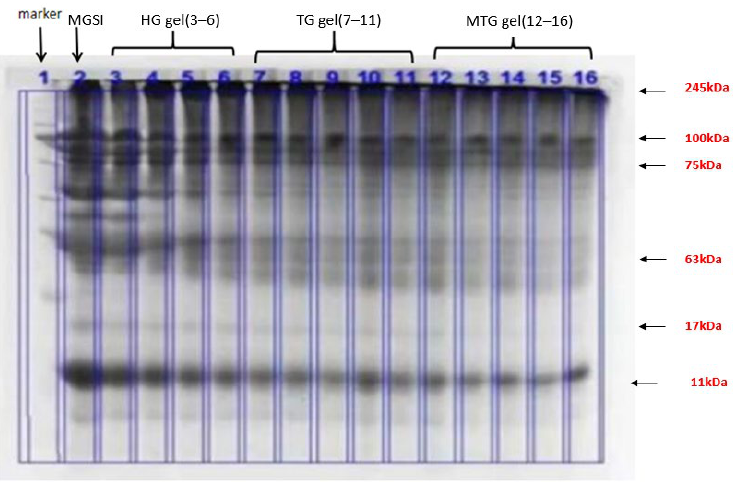
Figure 1. SDS-PAGE electrophoresis of the three protein gels.